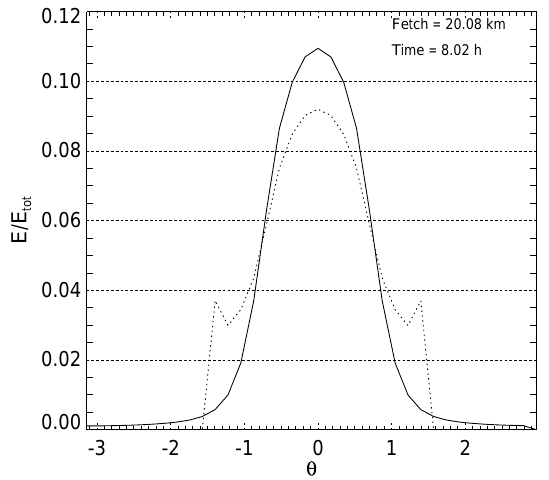
Figure 19. Relative wave energy distribution E(θ)/E tot = R f d R 2 π ε(ω,θ) d ω/ R f d ε(ω,θ) d ω d θ as the function of angle θ 0 f min f min for the duration limited (solid line) and limited fetch (dotted line) cases.